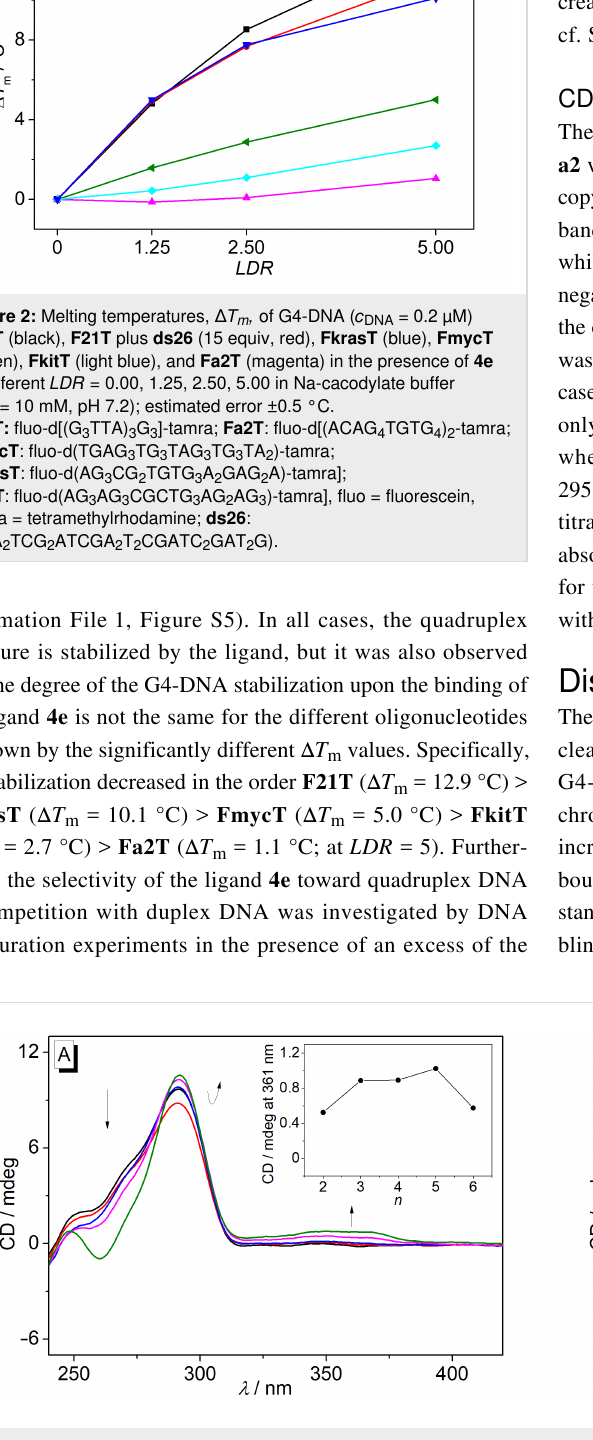
Figure 3: CD spectra of 22AG (A) and a2 (B) in the presence of the ligands 4c (in K + -phosphate buffer (pH 7.0 with 10% v/v DMSO) at LDR 0.00 (black), 0.05 (red), 0.20 (blue), 0.50 (magenta), and 1.00 (green); c DNA = 20 µM; T = 20 °C. The arrows indicate the development of the CD bands with increasing LDR . Insets: Plots of intensity of the ICD signal of the ligand–DNA mixtures (LDR 1.0; 361 nm) for 22AG (A) and a2 (B) versus the alkyl chain lengths n of 4a – e .